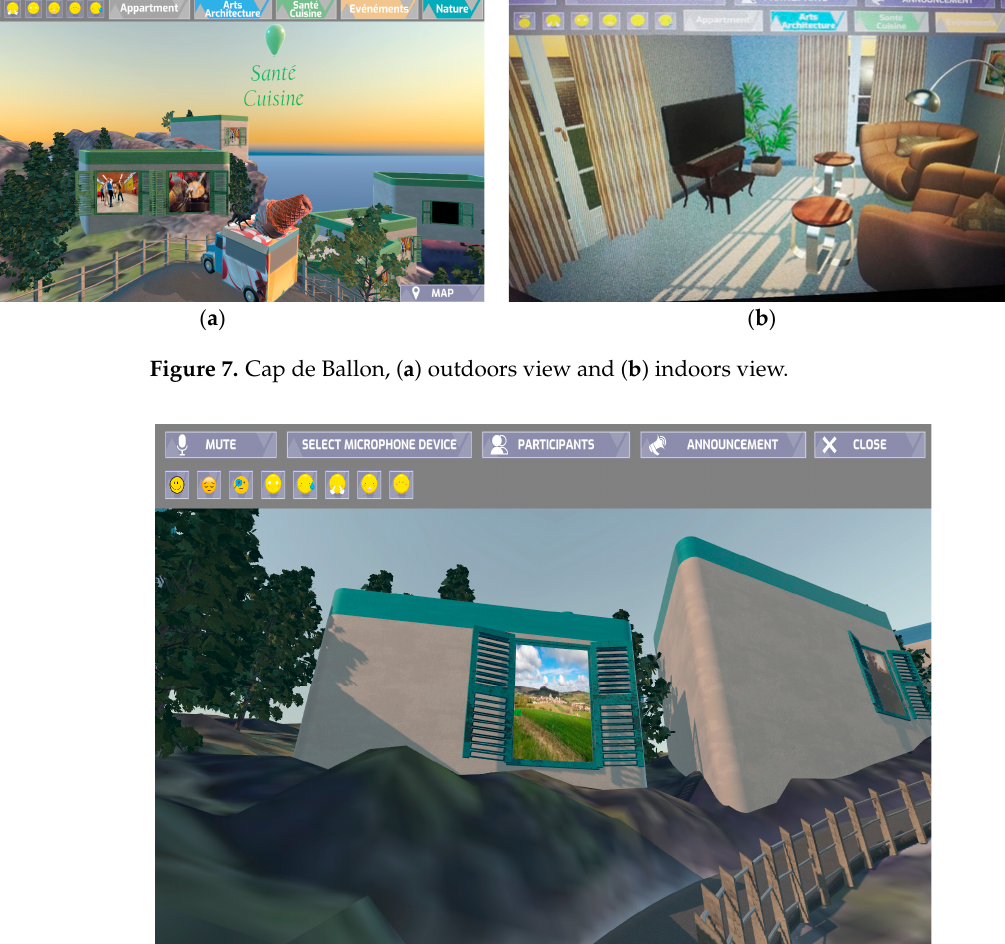
Figure 8. Cap de Ballon, content